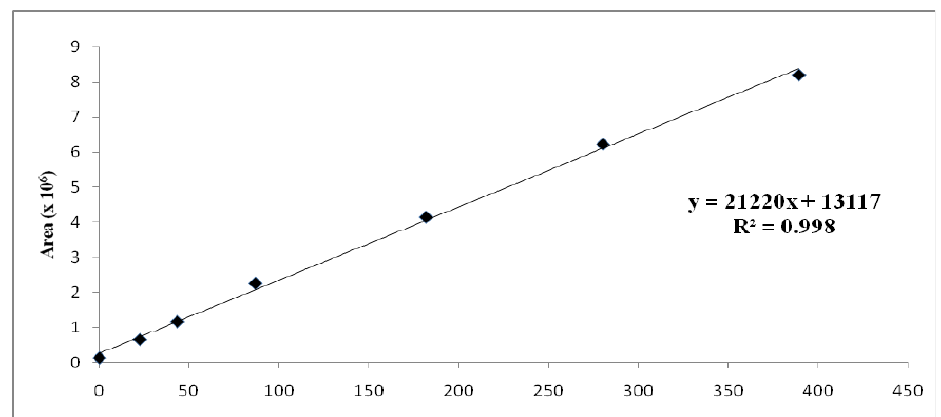
Figure 7. Calibration curve for